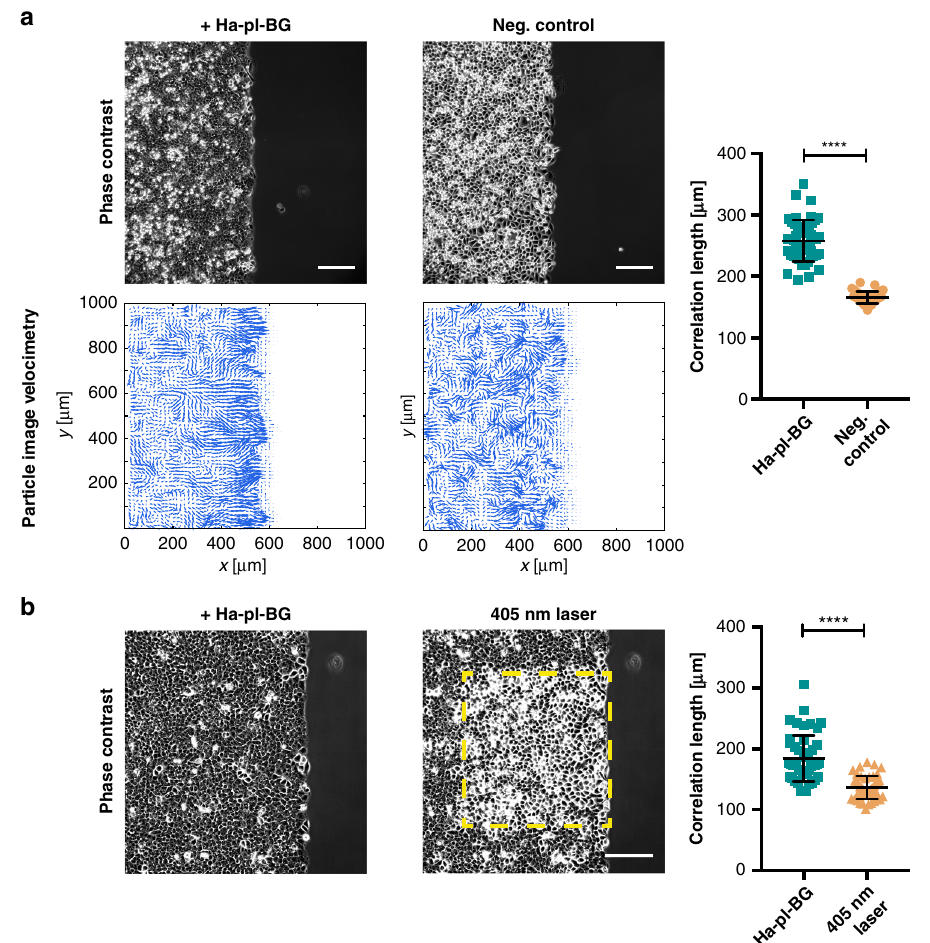
Fig. 5 LInDA has an impact on the collective behavior of epithelial monolayers. a PIV analysis of cell migration. Vector fi elds of cell velocities from two consecutive frames were calculated from phase contrast images to determine the lateral velocity correlation length as a measure of collectivity. Cells treated with Ha-pl-BG show a signi fi cantly higher velocity correlation length then the untreated control cells (neg. control). Scale bar 200 µ m. n = 192 (48 time points from 4 positions) for cells with dimerizer (dark green squares) and untreated control (orange circles), respectively. **** p < 0.0001 by unpaired t -test with Welch´s correction. b PIV analysis of dimerizer treated cells before and after light-induced dissociation of AJs shows a signi fi cant reduction of collectivity in the targeted cells as measured by the velocity correlation length. Scale bar 200 µ m. n = 48 (12 time points from 4 positions) for cells before (dark green squares) and after 405 nm exposure (orange circles), respectively. **** p < 0.0001 by unpaired t -test with Welch ʼ s